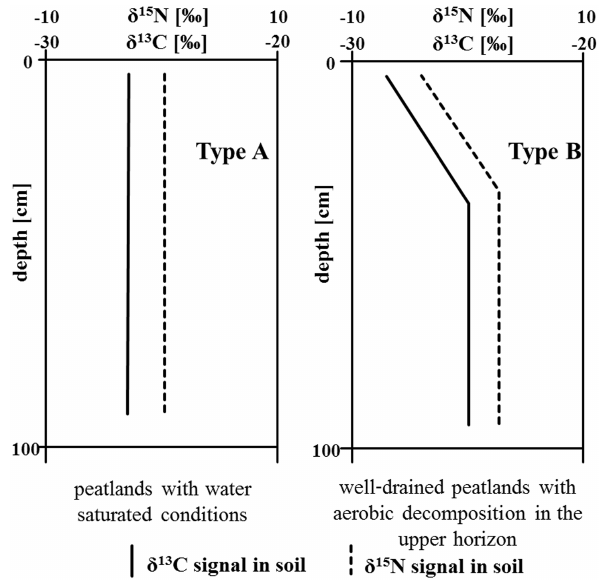
Figure 1. Theoretical concept of δ 13 C and δ 15 N depth profiles in natural (left) and degraded (right)